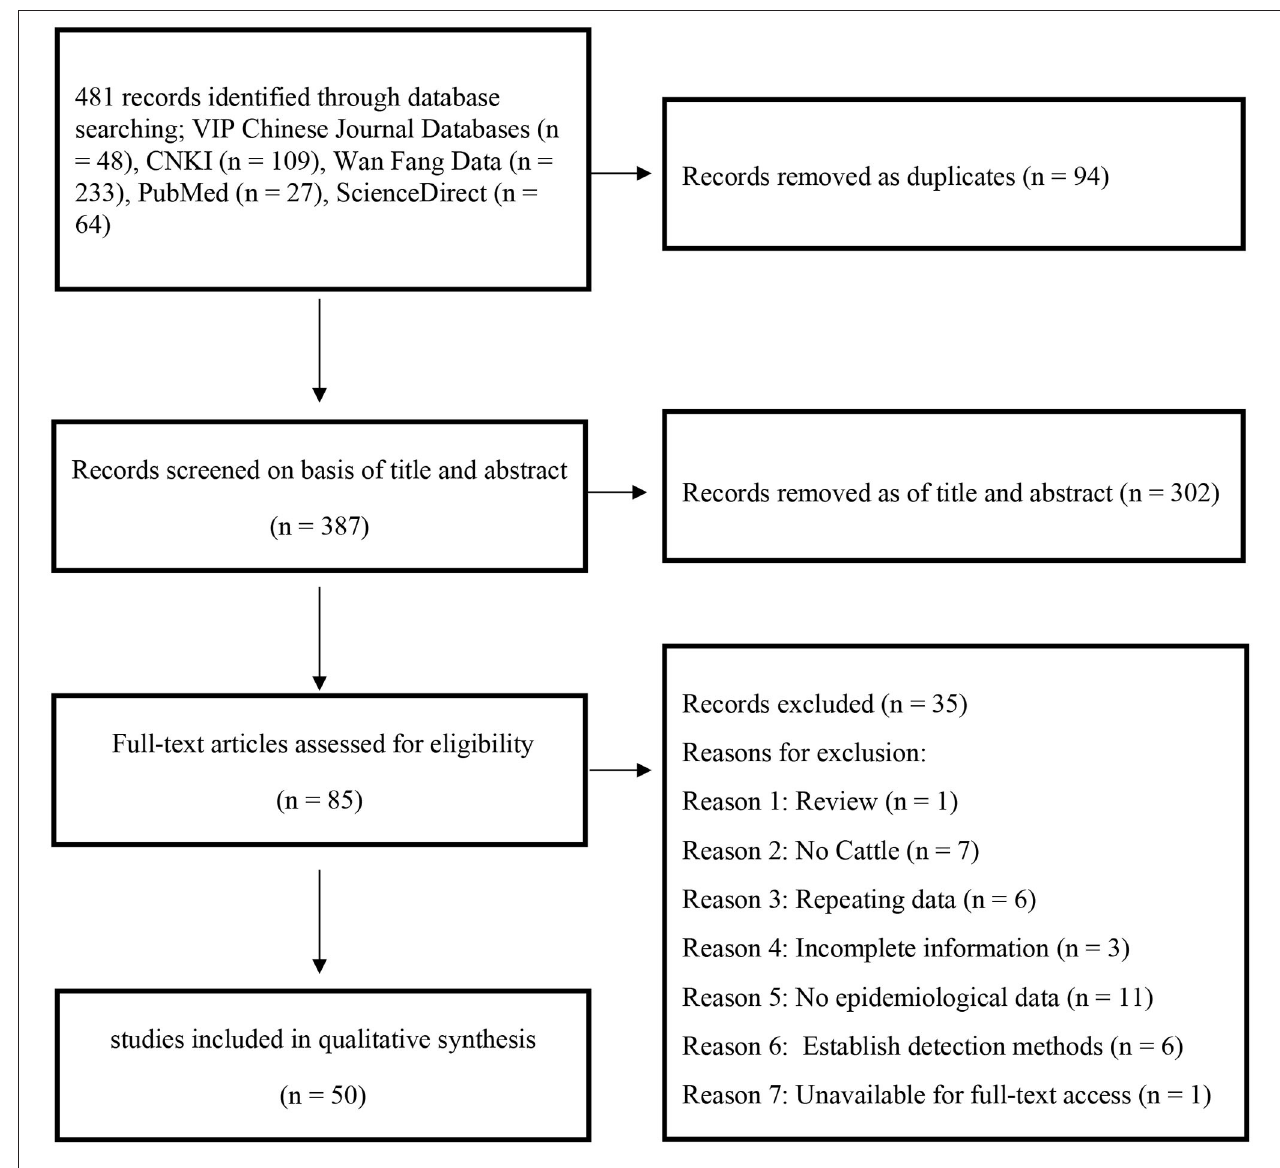
FIGURE 1 | PRISMA chart of the study selection process showing inclusion and exclusion of studies.